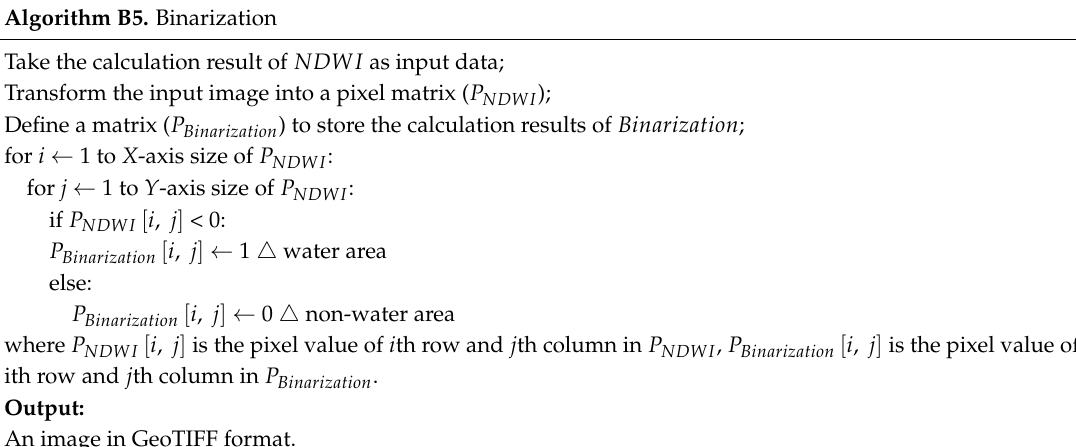
Algorithm B5. Binarization